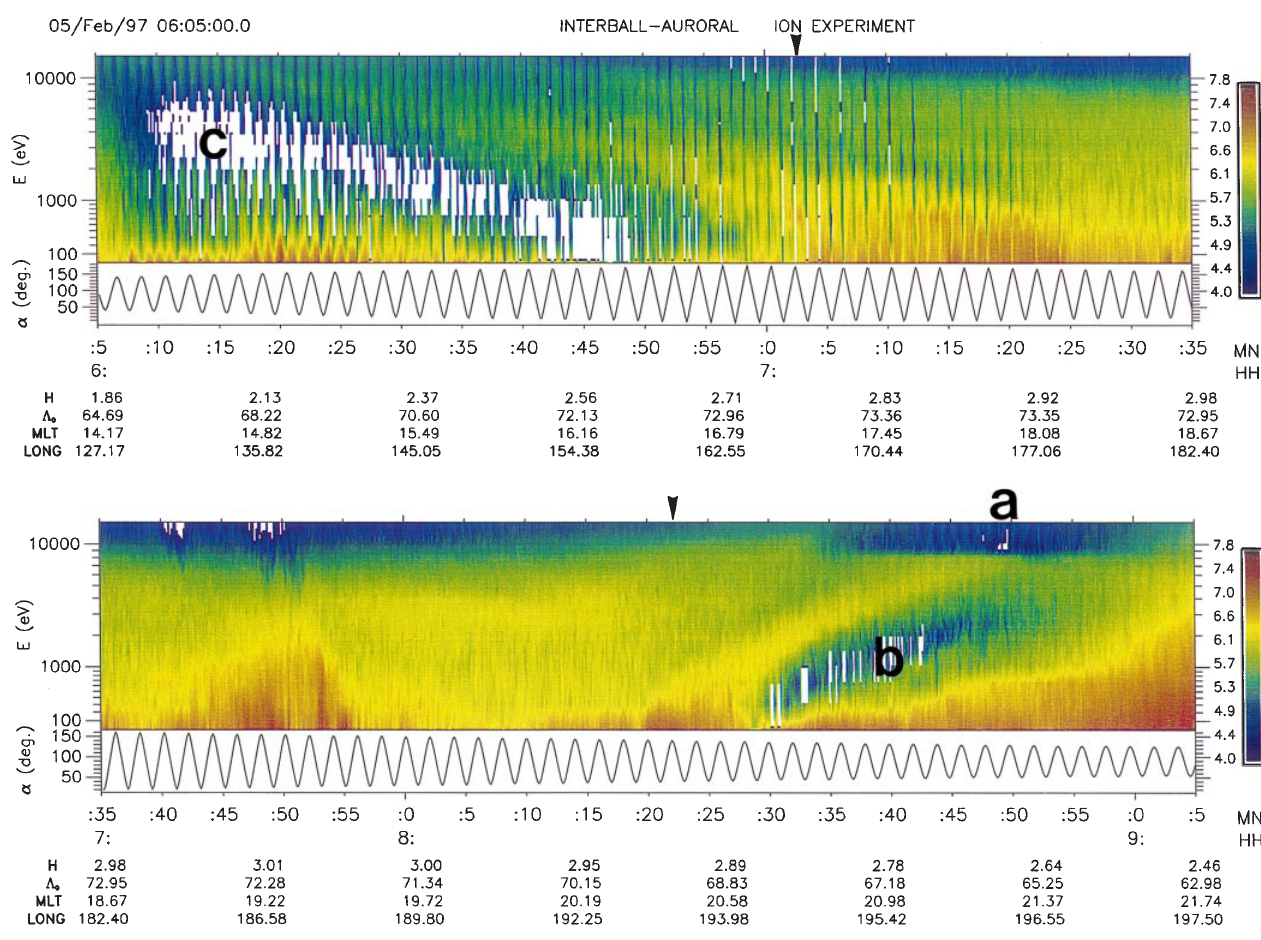
Fig. 2a, b. Ion energy-time spectrograms recorded by INTERBALL- Auroral on February 5, 1997: a in the afternoon sector (from 0605 UT until 0735 UT), b in the evening sector (from 0735 UT until 0900 UT).